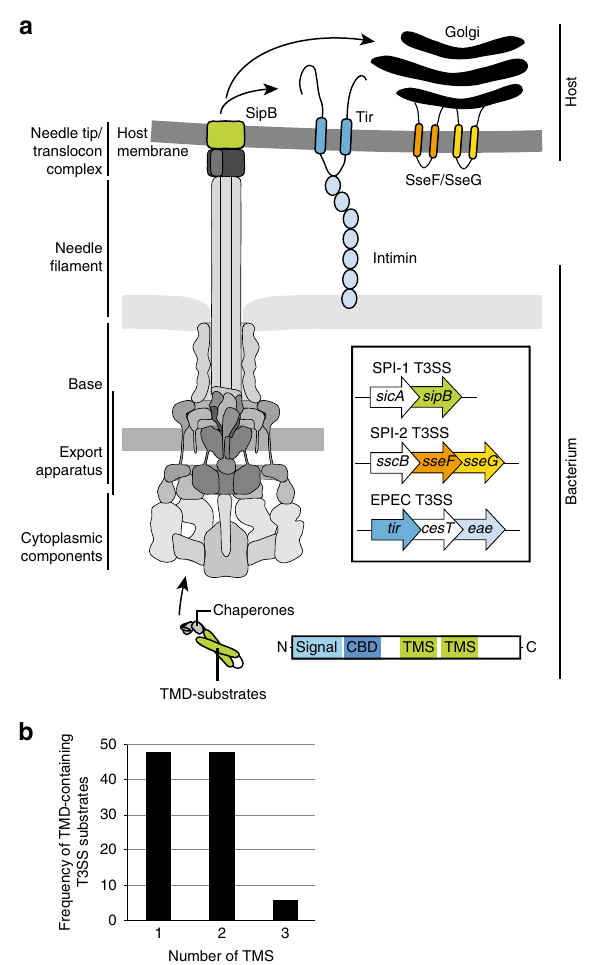
Fig. 1 Type III-secreted transmembrane proteins a Type III-secreted transmembrane proteins harbor an N-terminal type III secretion signal and a chaperone binding domain (CBD). They are targeted by cognate chaperones to the sorting platform (cytoplasmic components) of the T3SS injectisome. They are secreted into the host cell and incorporated into the host membrane. SipB (green) is a hydrophobic translocator of the SPI-1 T3SS of Salmonella , forming pores for T3SS effector translocation. SipB is targeted by the chaperone SicA. SseF (orange) and SseG (green) are effector proteins of the SPI-2 T3SS and targeted by the chaperone SscB. Both proteins interact with endosomal compartments e.g., the Golgi network. The Tir protein (blue) of EPEC is secreted through the T3SS and inserted into the host membrane in order to act as receptor for the adhesin intimin. Tir is targeted by the chaperone CesT. b T3SS substrates were analyzed using the full protein scan of the Δ G predictor (window: 18 – 35 aa, length correction: OFF). The histogram shows the distribution of the number of TMS of type III-secreted transmembrane proteins. CBD chaperone binding domain, IM inner membrane, OM outer membrane,